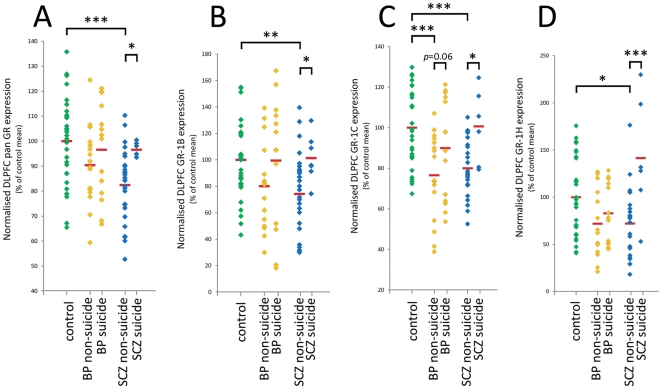
Effect of suicide on expression of GR mRNA transcripts in the DLPFC.Suicide-positive and suicide-negative control cases, bipolar disorder cases and schizophrenia cases were compared. A) Pan GR mRNA expression; B) GR-1B mRNA expression; C) GR-1C mRNA expression; D) GR-1H mRNA expression. For all transcripts, GR transcript expression was decreased in suicide-negative schizophrenia cases relative to suicide-positive schizophrenia cases and relative to controls (all suicide-negative). For the GR-1C mRNA transcript, expression was decreased in bipolar disorder as well as schizophrenia in suicide-negative cases relative to both suicide-positive cases and controls. Green, orange and blue diamonds represent control, bipolar disorder and schizophrenia cases respectively. Red bars represent group means. Abbreviations: BP- bipolar disorder, SCZ- schizophrenia. * p≤0.05, ** p<0.005, *** p<0.0005.